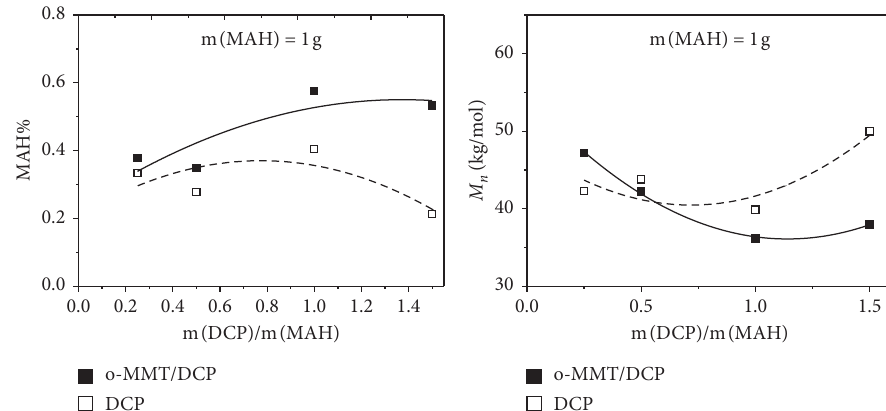
Figure 5: Comparison between the PP/DCP/MAH and PP/(DCP/o-MMT)/MAH grafting systems in terms of the evolution of the grafting degree and that of the molar mass of the PP-g-MAH as a function of the DCP content for a given MAH